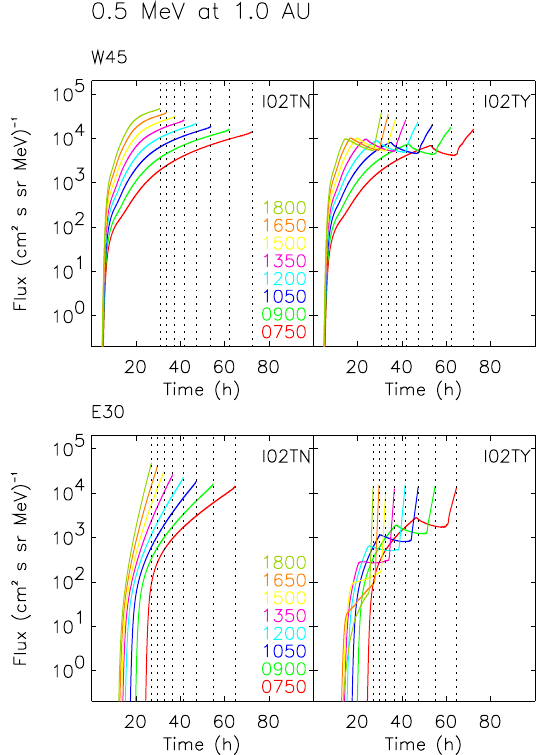
Fig. 1. SOLPENCO: Two examples of the flux profiles of the data base. Synthetic 0.5 MeV proton flux profiles for two observers located at 1 AU and at W45 and E30 of heliolongitude (two top and two bottom panels, respectively). The initial velocity of the eight simulated shocks is color coded (from top to bottom, v: 1800, 1650, 1500, 1350, 1200, 1050, 900, and 750kms − 1 ), as indicated in the inset of the left panel. The particle mean free path assumed is λ = 0.2 AU. Vertical dashed lines mark the arrival time for each shock at the observer’s location. Left panels show the respective flux profiles without assuming the existence of a foreshock region ahead of the shock. Right panels show the same profiles, assuming the existence of such a